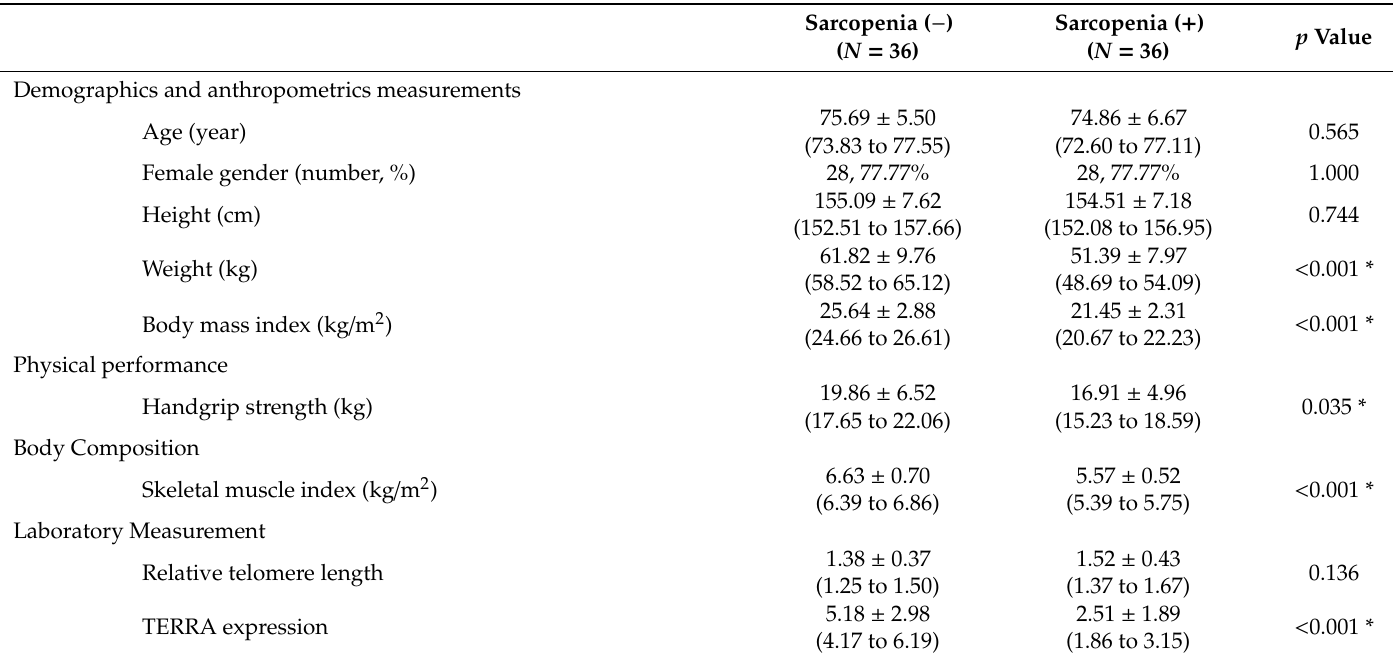
Table 1. Demographics, physical performance, body composition and T / S ratio for telomere length and TERRA expression the study